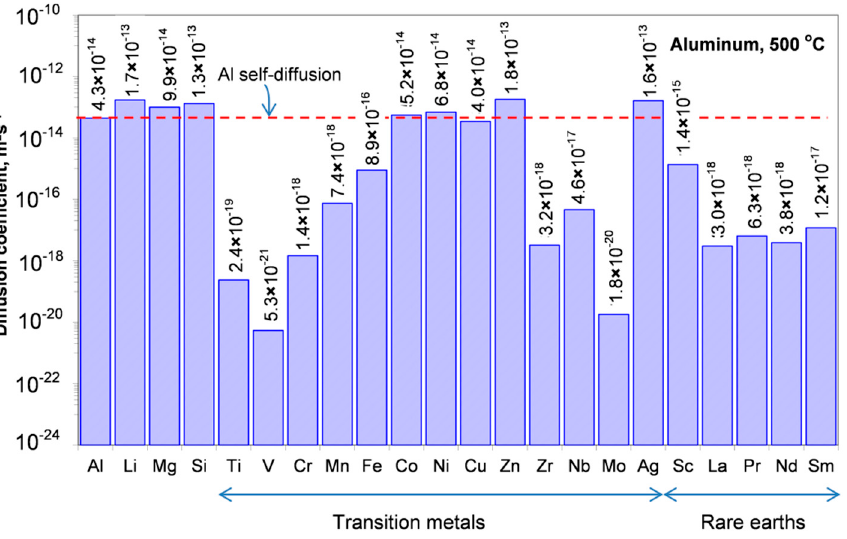
Figure 9. Calculated diffusion coefficients at 500 °C of selected alloying elements in aluminum, representing transition metals, rare earth and general elements, along with aluminum self-diffusion. Plot based on data from Tables A1–A3 in Appendix A.